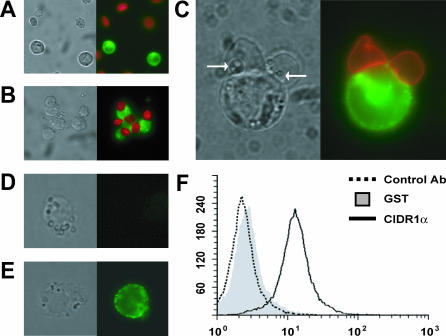

P. falciparum iRBCs and Soluble CIDR1α Bind to the EBV-Positive B Cell Line Akata(A–C) Akata cells stained with PKH67 (green) were co-incubated with RBCs stained with PK26 (red) (A) or with purified iRBCs (B, C) at a ratio of 1:2 (Akata:iRBC). Binding was evaluated by light microscopy (left panel) and immunofluorescence microscopy (right panel). (C) Magnification of the binding between iRBCs and Akatas. Localization of the parasite in the iRBC (indicated by white arrows) was revealed using phase contrast microscopy (left panel).(D–F) Akata cells were incubated with soluble GST (1 μM) (D) or CIDR1α (1 μM) (E) for 1 h at RT and stained with anti-GST Ab and anti-mouse Alexa-488-conjugated Ab. The binding was evaluated by light microscopy (left panel, [D, E]), immunofluorescence microscopy (right panel, [D, E]), and fluorescent-activated cell sorting (FACS) analysis (F).